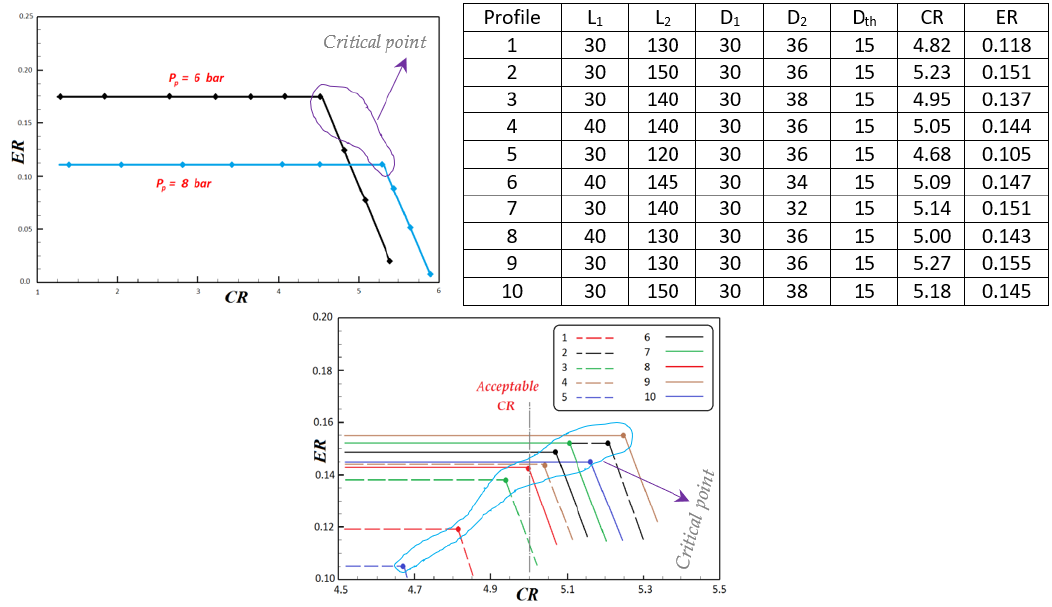
Figure 7. Performance curve of an ejector for designed and operating pressures, 6 bar and 8 bar (source [57]).